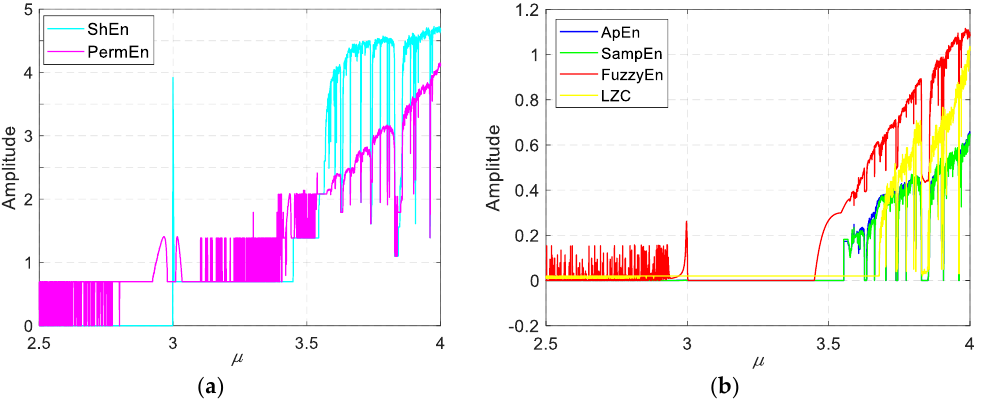
Figure 11. The six complexities of the logistic map. ( a ) ShEn and PermEn, ( b ) ApEn, SampEn, FuzzyEn and LZC.